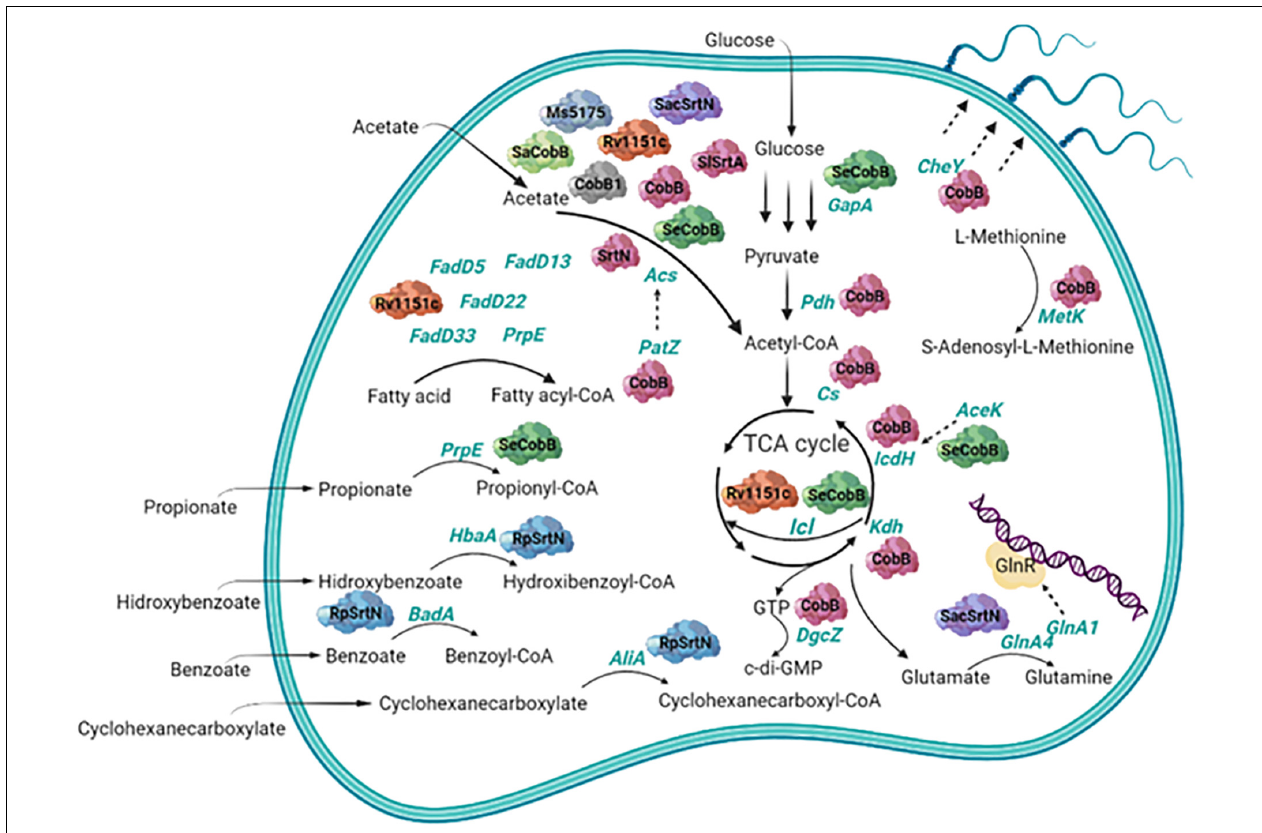
FIGURE 1 | Scheme of the role of bacterial sirtuins in carbon and nitrogen metabolism. Deacetylated substrates are shown in green font and the bacterial sirtuins that deacetylate them have been represented as enzymes of different colors. Sirtuins shown here are represented with the abbreviated names and belong to different species. Correspondence with the full name and species for each one can be found throughout the